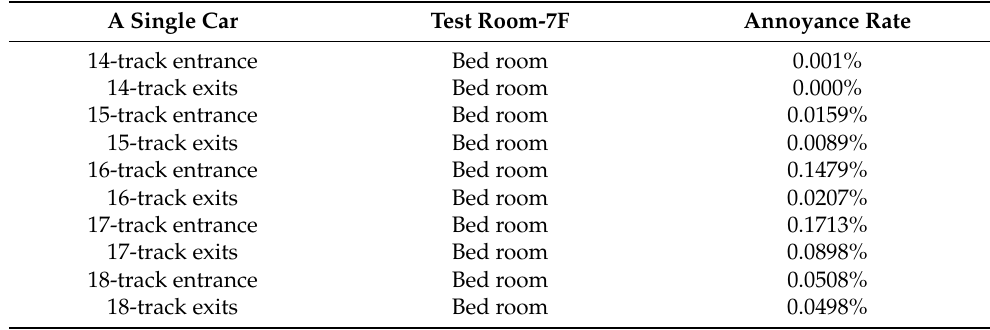
Table 13. Vibration annoyance rate of the seventh-floor test room during a single-train operation based on annoyance rate